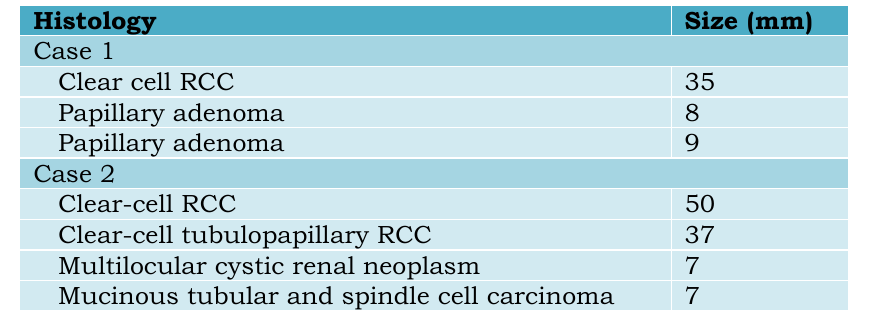
Table 1. Histological Diagnosis of